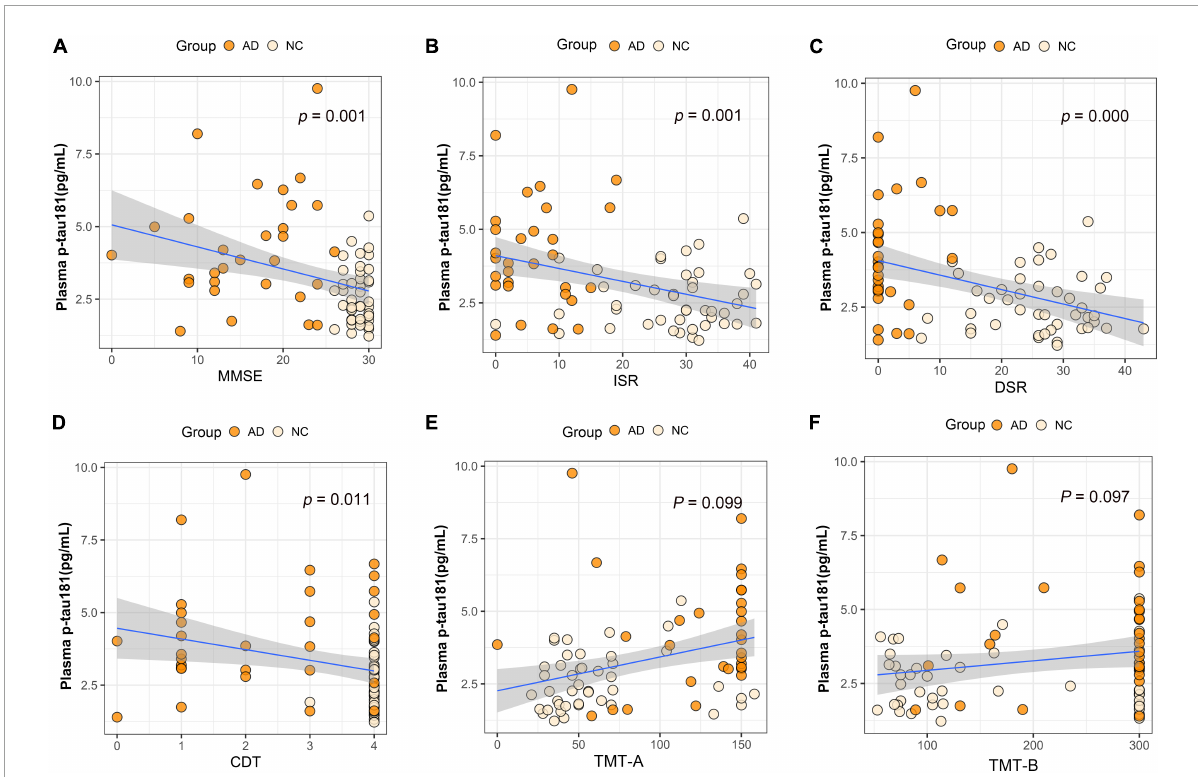
FIGURE3 Association between plasma p-tau181 and cognitive domains. (A) Association between plasma p-tau181 and MMSE. (B) Association between plasma p-tau181 and ISR. (C) Association between plasma p-tau181 and DSR. (D) Association between plasma p-tau181 and CDT. (E) Association between plasma p-tau181 and TMT-A. (F) Association between plasma p-tau181 and TMT-B. Multiple regression analysis was used and adjusted for years of education. AD, Alzheimer’s diseases; NC, normal control; MMSE, Mini-Mental Status Examination; ADL, Activity of Daily Living; ISR, Immediate story recall; DSR, delayed Story Recall Scale; CDT, clock drawing test; TMT-A, trail making test A; TMT-B, trail making test B; pg/ml,